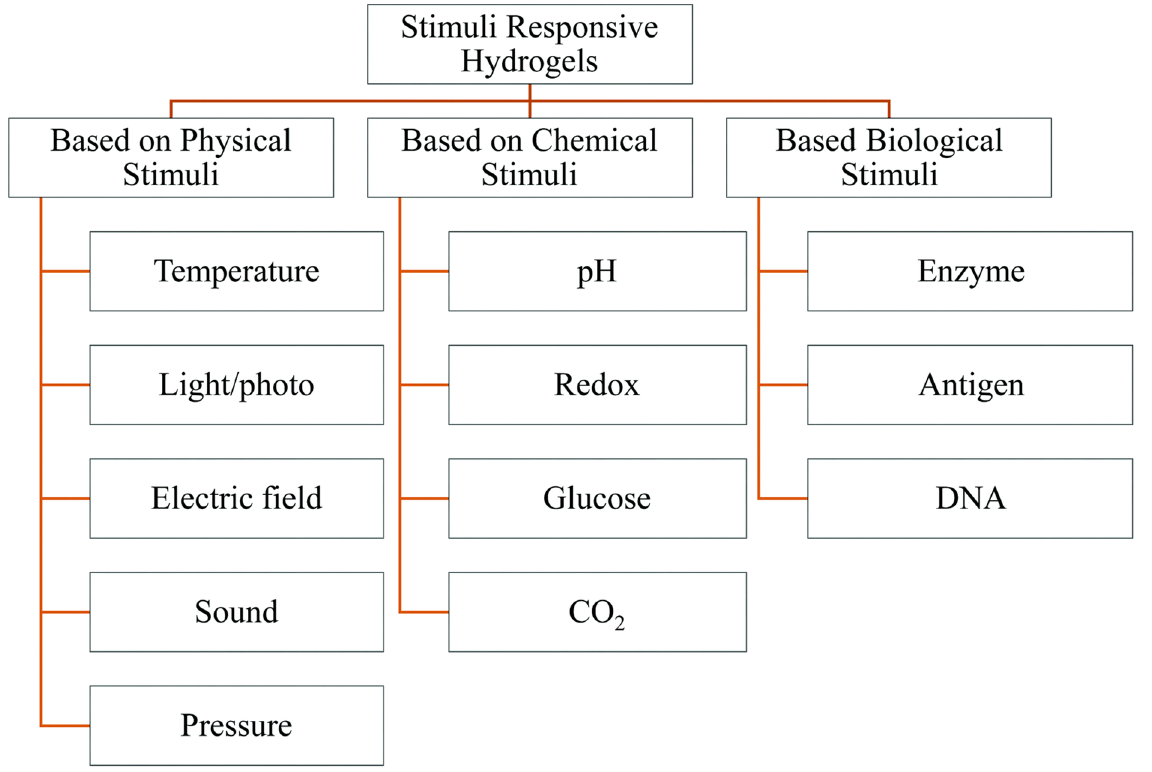
Figure 1. Classification of stimuli-responsive hydrogel based on physical, chemical, and biological stimuli. Reproduced with permission from Sikdar et al. [3], ©The Royal Society of Chemistry, 2021.